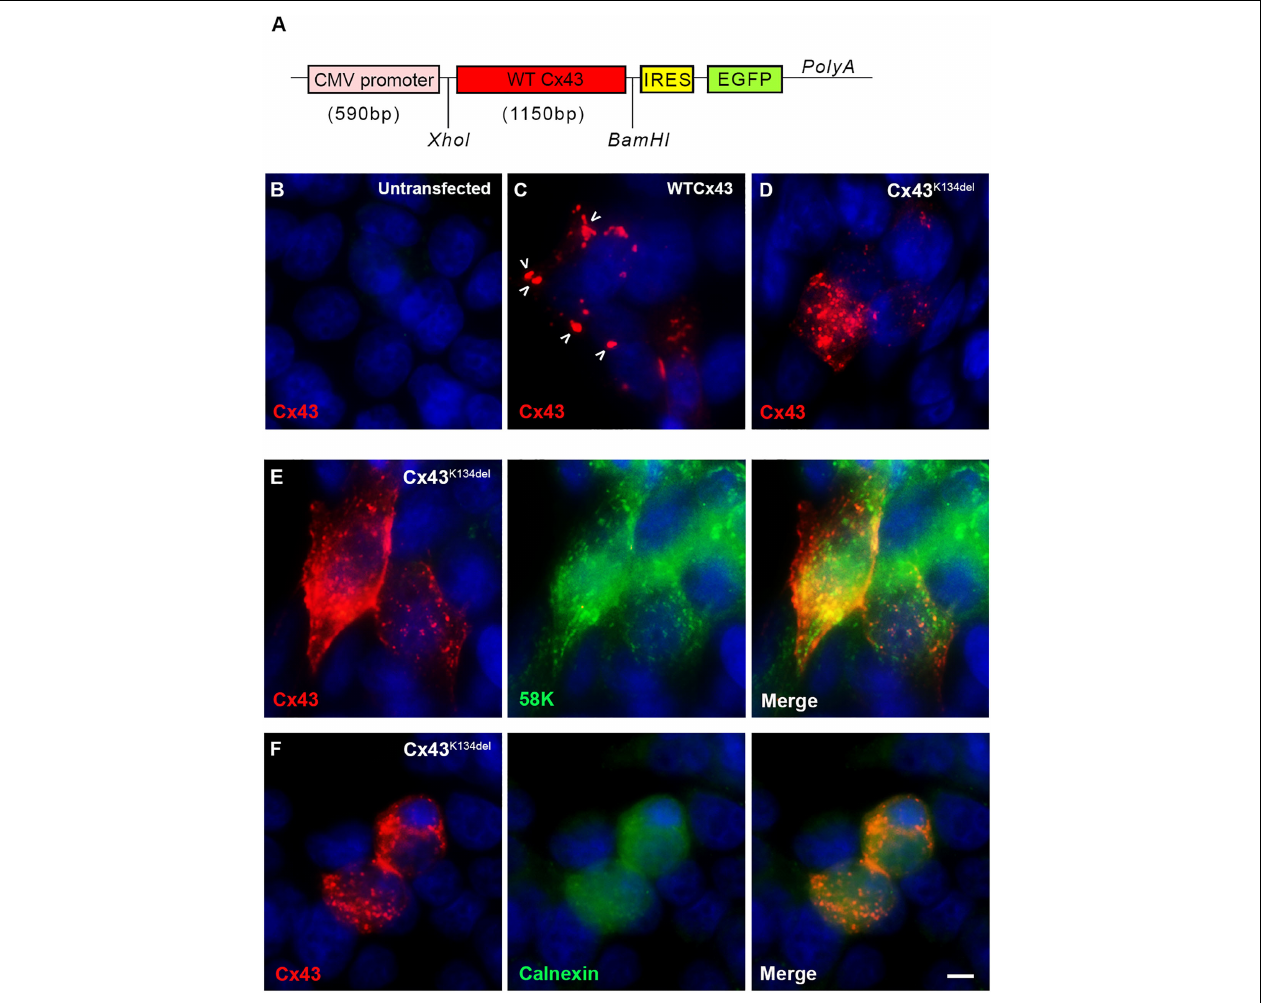
FIGURE 3 | Localization of Cx43 K134del . Diagram of the expression cassette used in the cell expression studies (A) . Immunofluorescence staining for Cx43 (red) in untransfected HeLa cells used as negative control (B) or transfected cells expressing either WT Cx43 (normal sized plaques are marked with arrows) (C) or the Cx43 K134del mutant (D–F) reveals that in contrast to the formation of GJ plaques by WT Cx43, the Cx43 K134del mutant is localized intracellularly (D) in the ER-Golgi compartment as confirmed by further double staining with either the Golgi marker 58k (E) or the ER marker calnexin (F) (both in green). Cell nuclei were counterstained with DAPI (blue). Scale bar = 10 µ